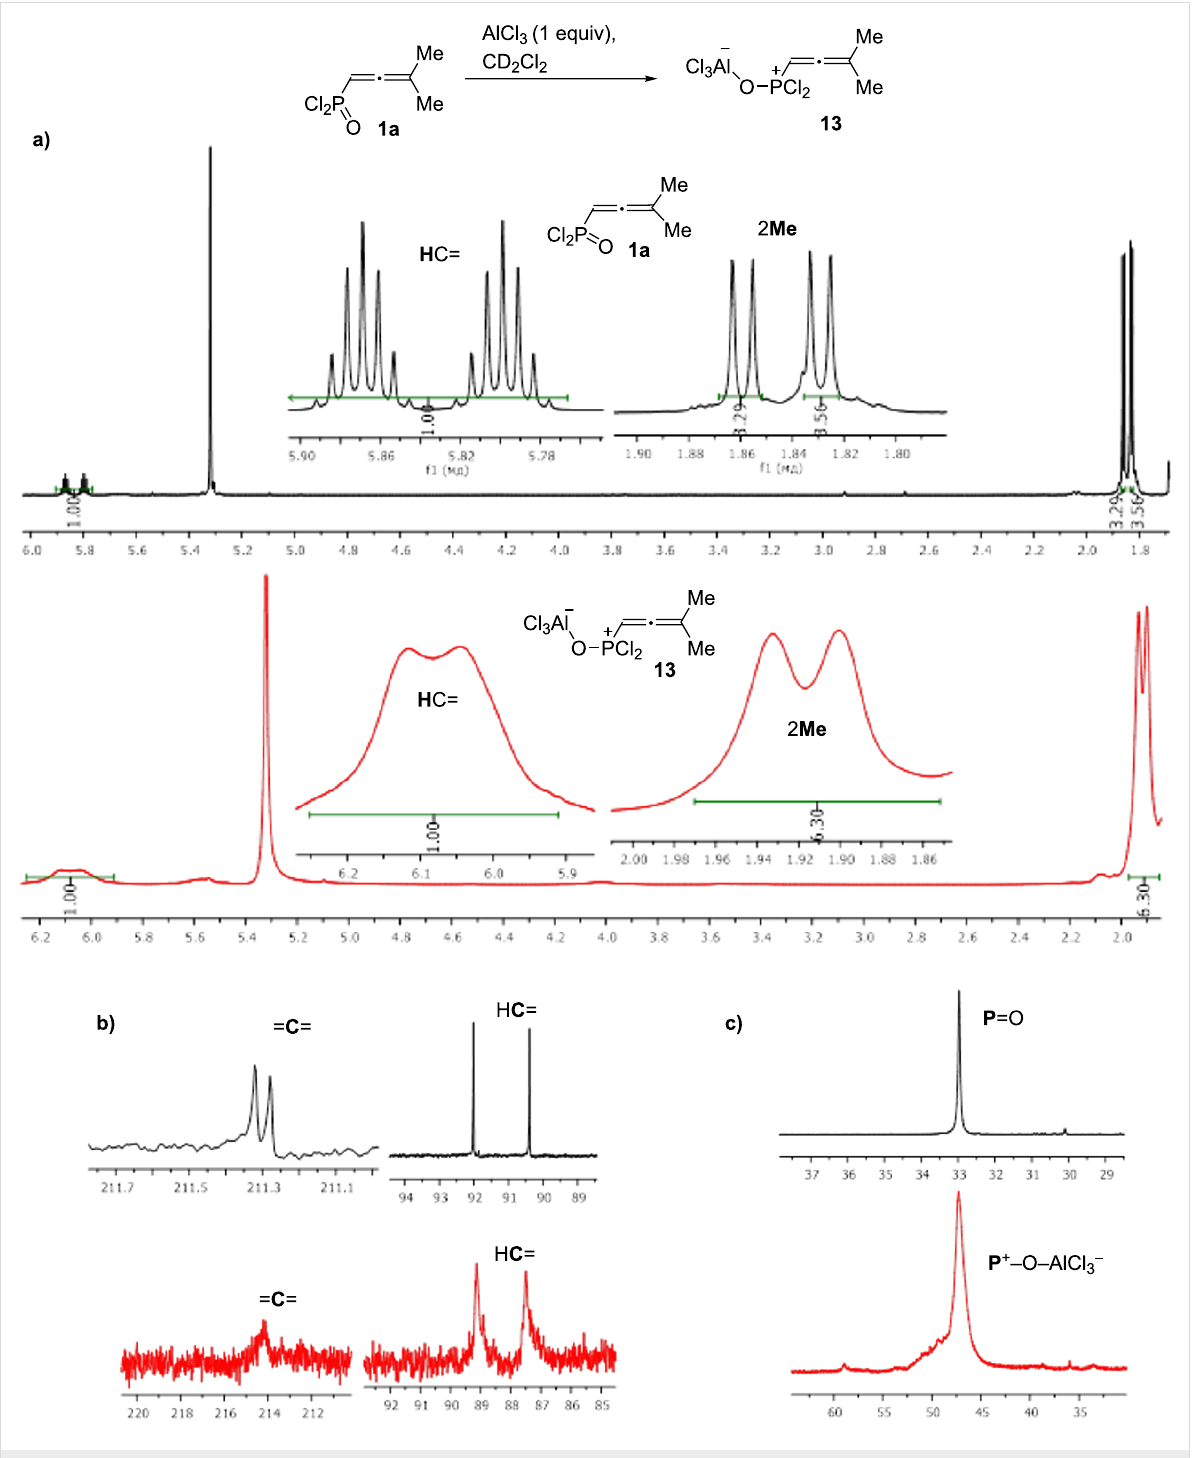
Figure 3: NMR spectra of starting allene 1a (black) and its complex with 1 equivalent of AlCl 3 13 (red) in CD 2 Cl 2 at room temperature: (a) 1 H NMR, (b) 13 C NMR (selected signals, doublets due to 13 C– 31 P spin–spin interaction), (c) 31 P NMR.